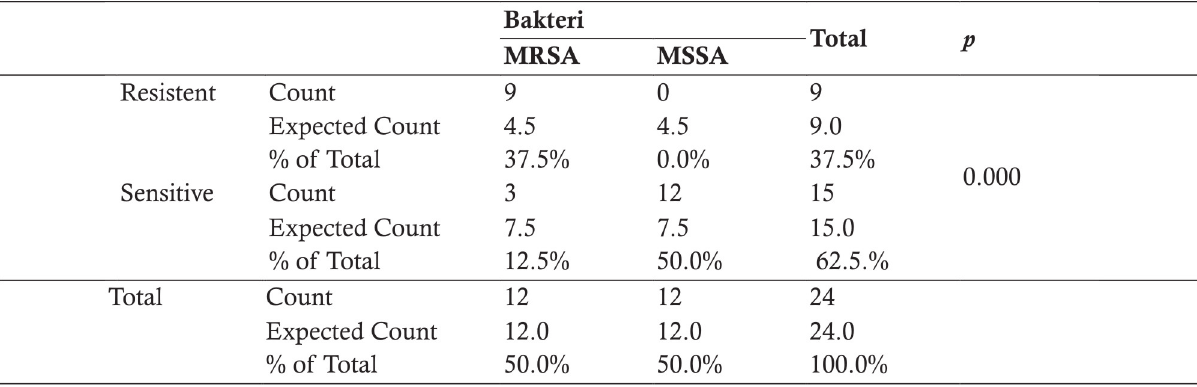
Difference on Cefoxitin and Oxacillin Disk Test on in Vitro ...